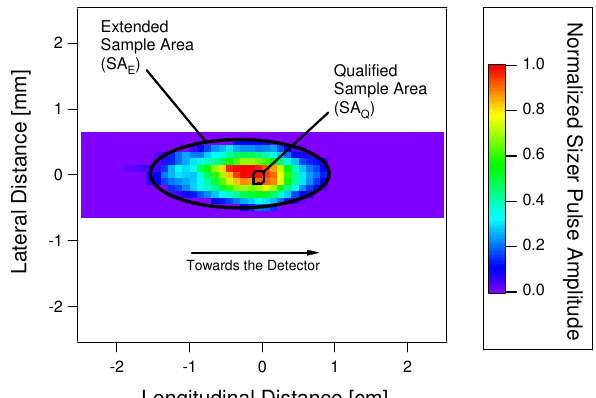
Fig. 9. Calibration of the Qualified Sample Area (SA Q ) and Ex- tended Sample Area (SA E ) for 22µm water droplets. Longitudinal and lateral directions shown in Fig. 3. The color scale shows the sizer pulse amplitude for droplets transiting through that location, normalized to the maximum sizer pulse amplitude at the center of the sizer DoF. Note that the longitudinal scale is a factor of ten times the lateral scale.